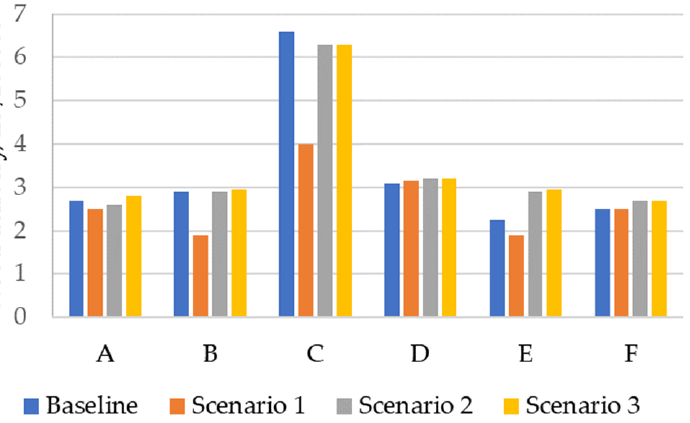
Figure 5. Comparison of changes in total wood-delivery volumes by wood-procurement regions (A–F). At the wood-procurement region level, the greatest inter-regional sensitivity to changes in the production situation was in wood-procurement region three. Correspondingly, the smallest sensitivity was in wood-procurement region six (Table 4). Results were based on the average variations in the delivering